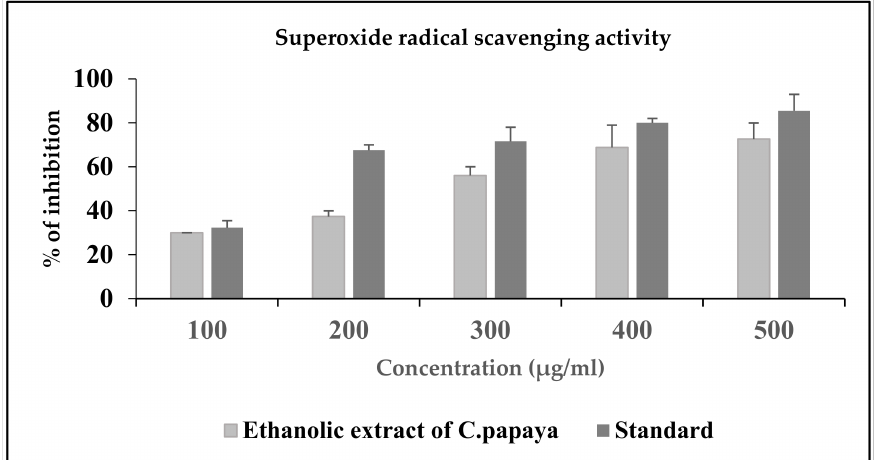
Figure 3. SO radical scavenging activity of the ethanolic extract of C. papaya. Each bar represents the mean ± SEM of five